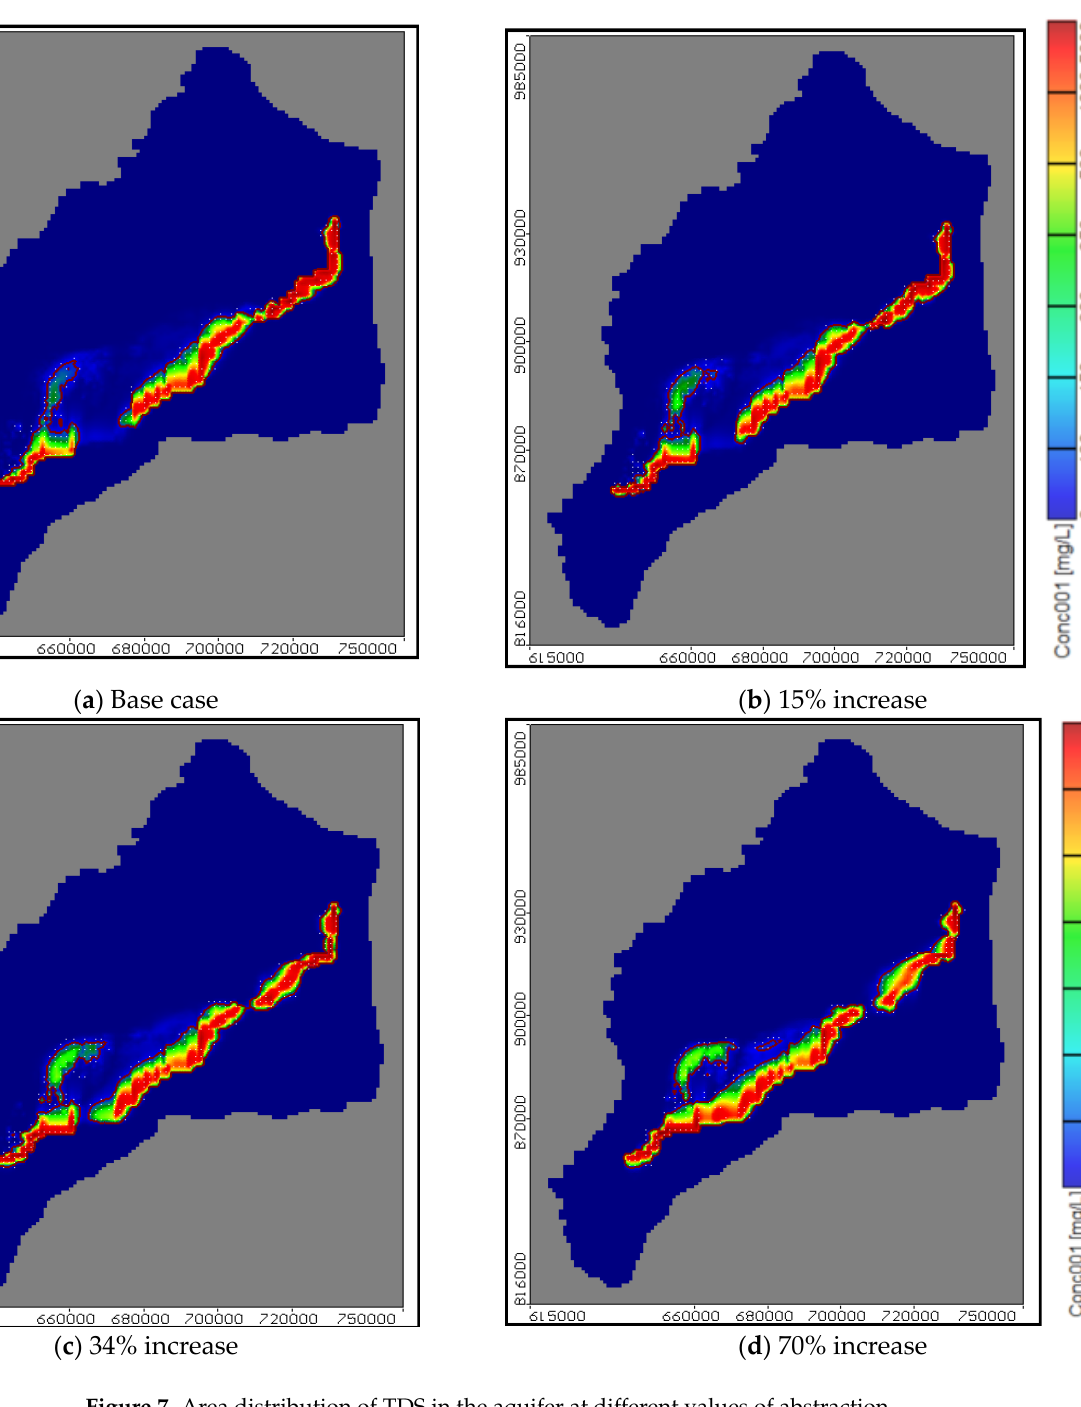
Figure 7. Area distribution of TDS in the aquifer at different values of abstraction.